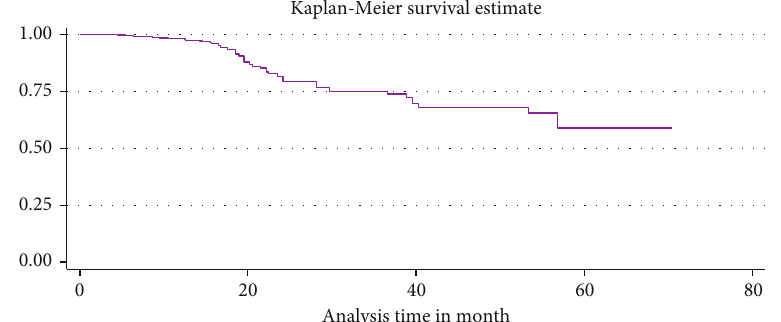
Figure 3: Overall Kaplan Meier survival estimate for all HIV/AIDS care seropositive children care started in two hospitals between 2011 and 2020 North West Ethiopia 2021 ( N = 421 ).